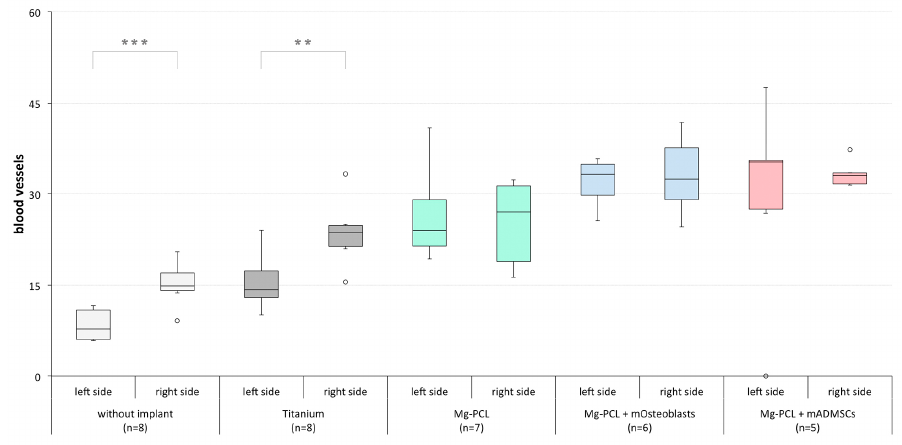
Figure 14. Comparison of counted intraosteal blood vessels of both skull sides within each experimental group (without an implant, with uncoated titanium implants, non-previtalised Mg-PCL implants and Mg-PCL implants previtalised with either mOsteoblasts or mADMSCs; ** = p < 0.01; *** = p < 0.001; whiskers = minimal and maximal values; horizontal line = median; circles = outliers).